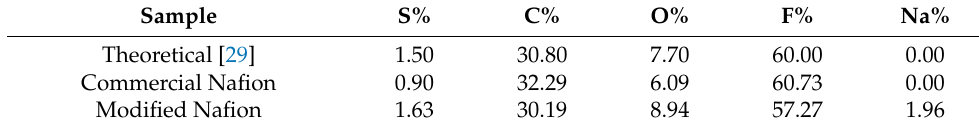
Figure 5. XPS survey scans of the commercial Nafion ( a ) and modified Nafion ( b ). Table 1. XPS quantitative elemental analysis of theoretical, commercial and modified Nafion.